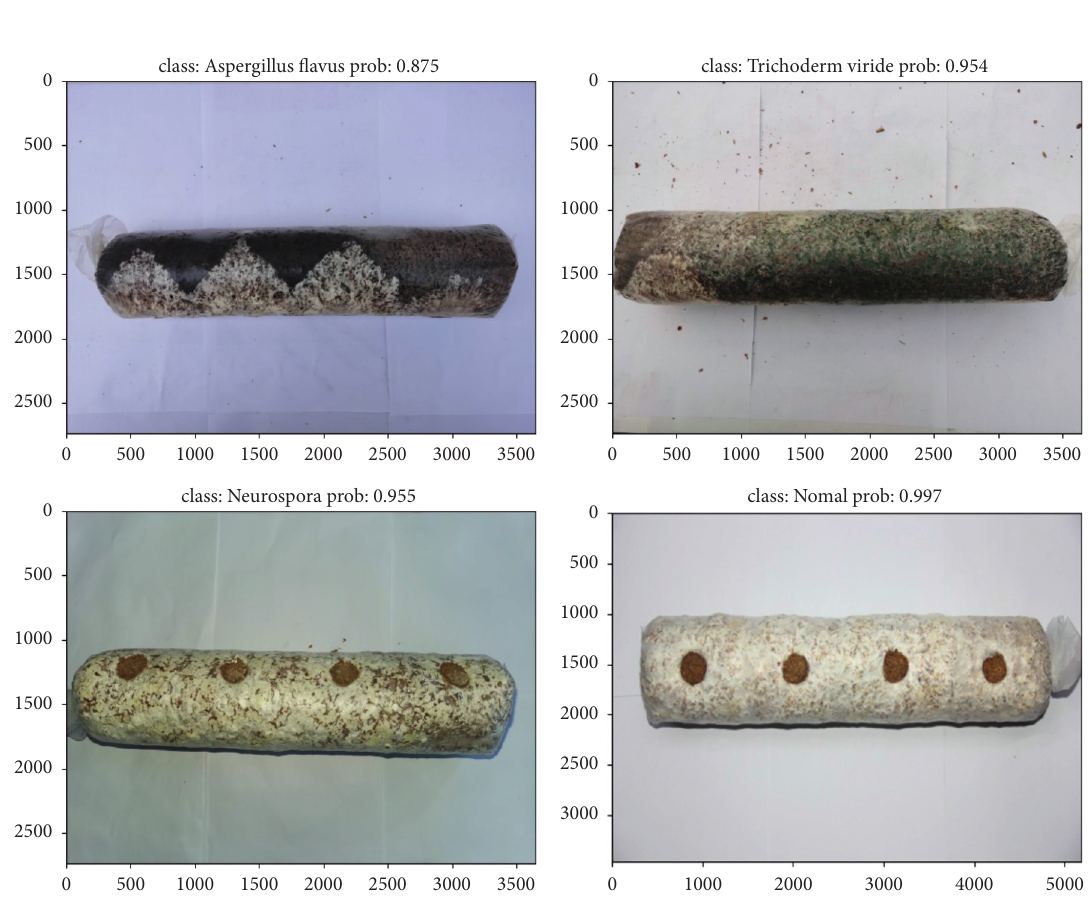
Figure 4: Part of the prediction